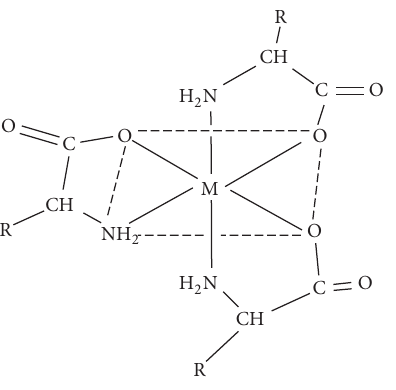
Figure 4: The proposed structure for the tris-chelate complexes. R = –H; glycinato complexes; –CH 2 COOH; aspartato